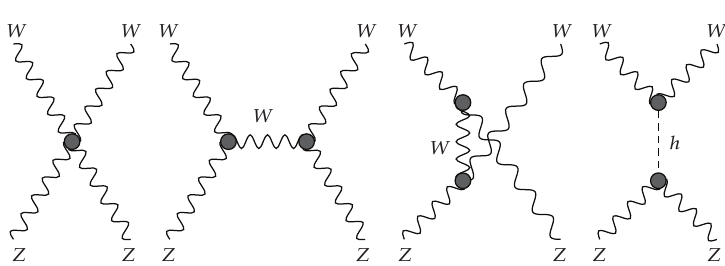
Figure 5: Diagrams contributing to W L Z L scattering in the MSM, yielding the amplitudes M 4 , M s , M u and M (cid:5) left to right (cid:6) h